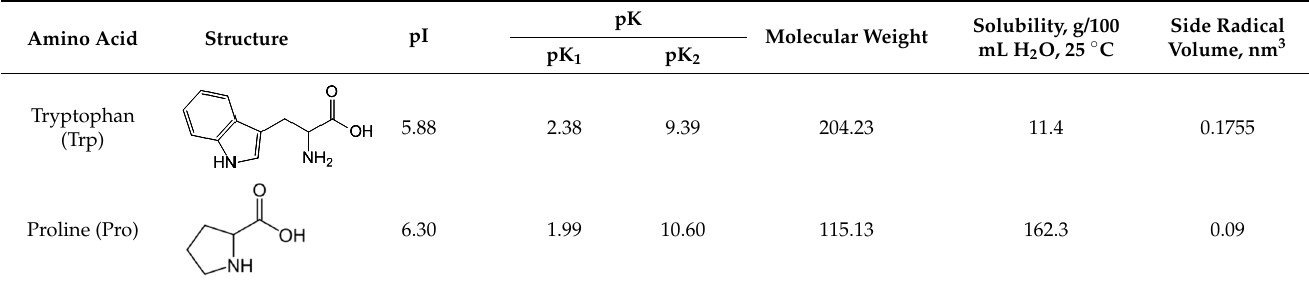
Table 1. The properties of the studied heterocyclic amino acids.